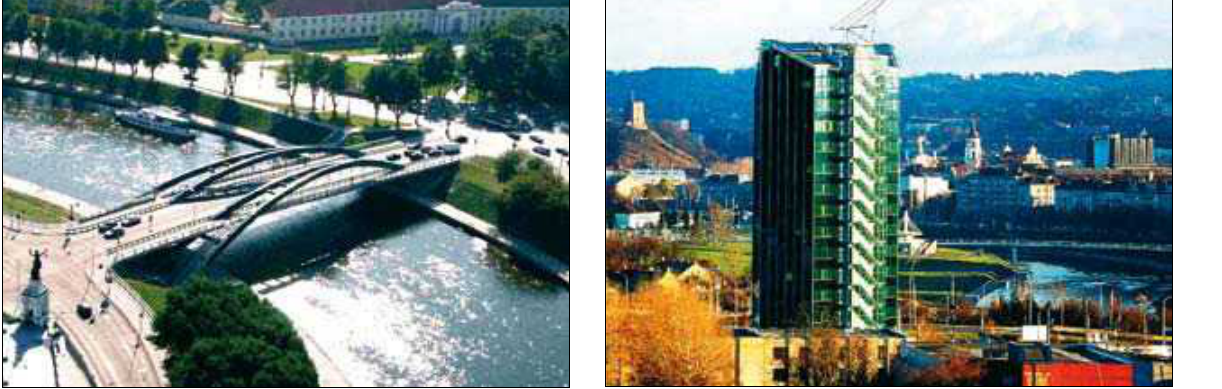
market economics disobeying planning regulations that are set in competition conditions (Lagunovičius 2001). Enhanced mortgage rate got a huge amount of economic benefit (by competition rules the building height is 7 storeys; due to some circumstances the building became 16-storey during implementation)